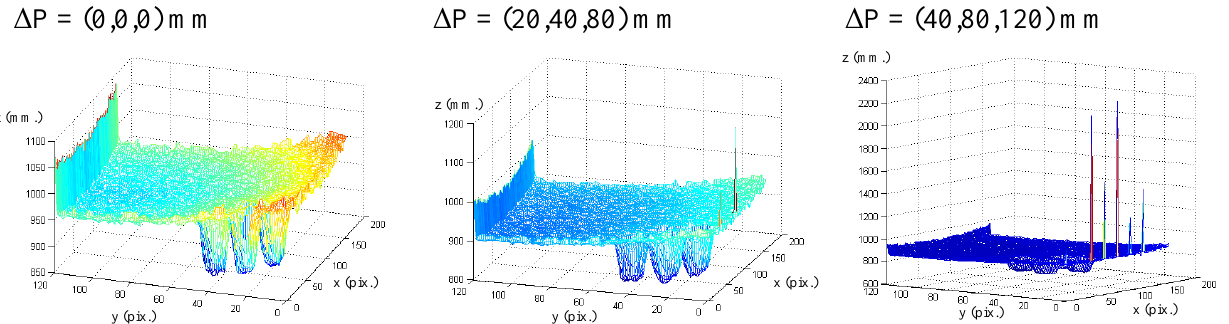
Figure 7. Range Image computed for the integration time of 53